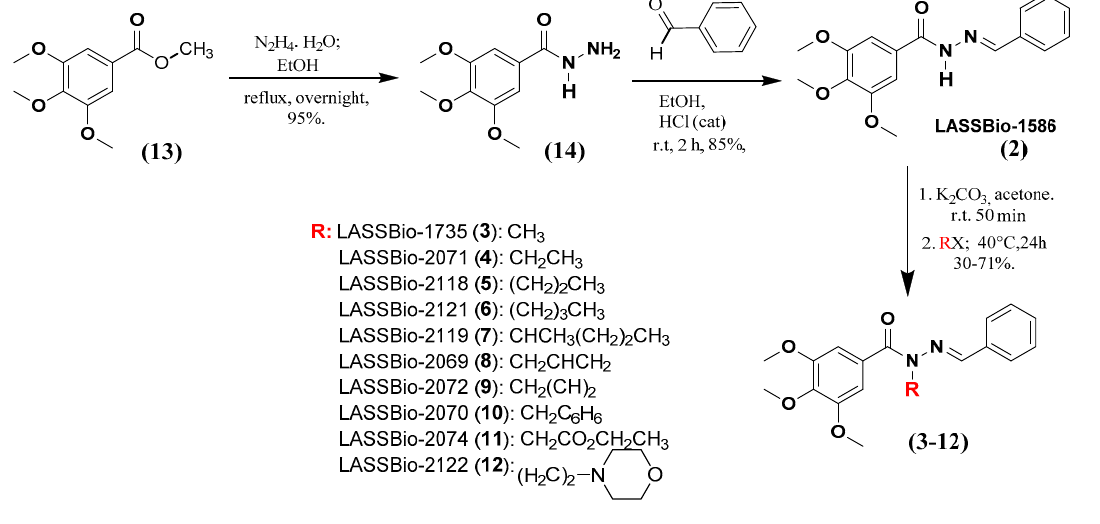
Figure 2. Synthetic methodology to obtain LASSBio-1586 ( 2 ) homologs and analogues from the starting material 13 . Table 1. Overall yields, physical aspect, melting point, purity by HPLC and retention time of compounds 2 – 12 .